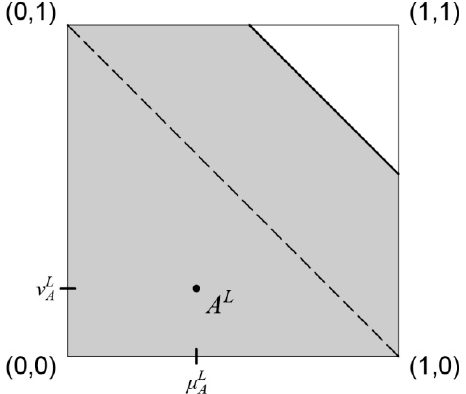
Figure 7. Interpretational surface of GIFS-L for L = 0.6.